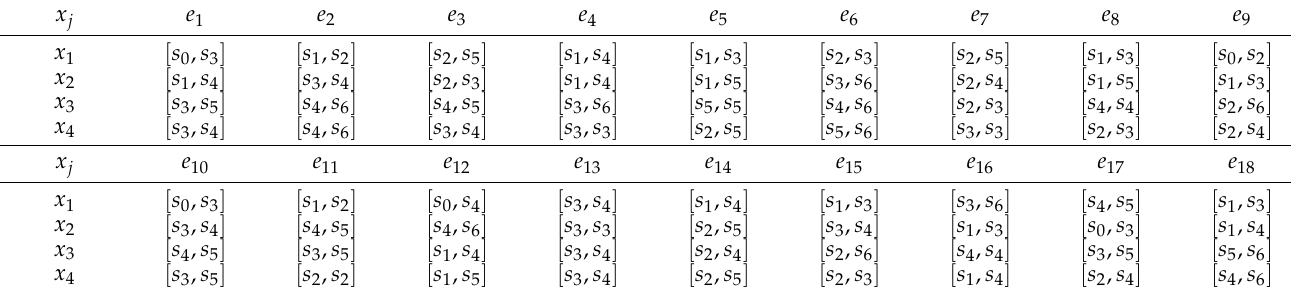
Table 2. Decision information of decision makers about alternatives.